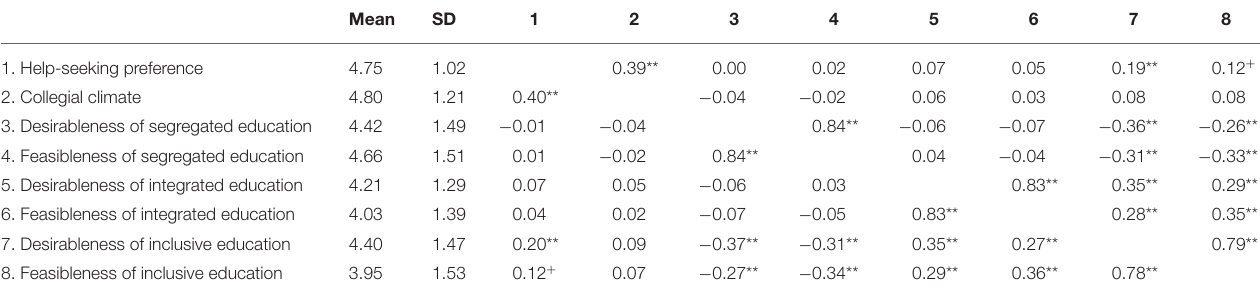
TABLE 1 | Descriptive statistics and correlation co-efficients between individual and environmental factors and evaluation scores of desirableness and feasibleness. Mean SD 1